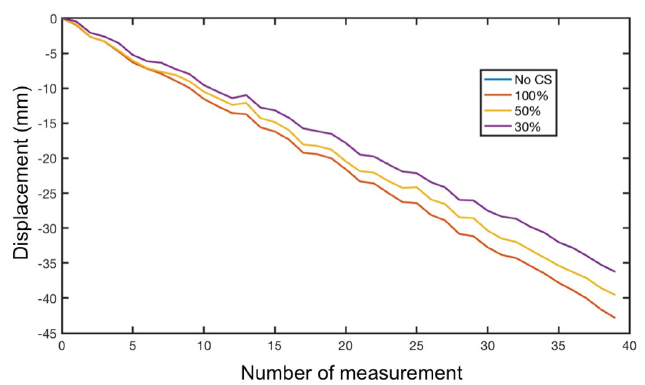
Figure 23. Cumulative measured displacement of the point B in the open pit mine.